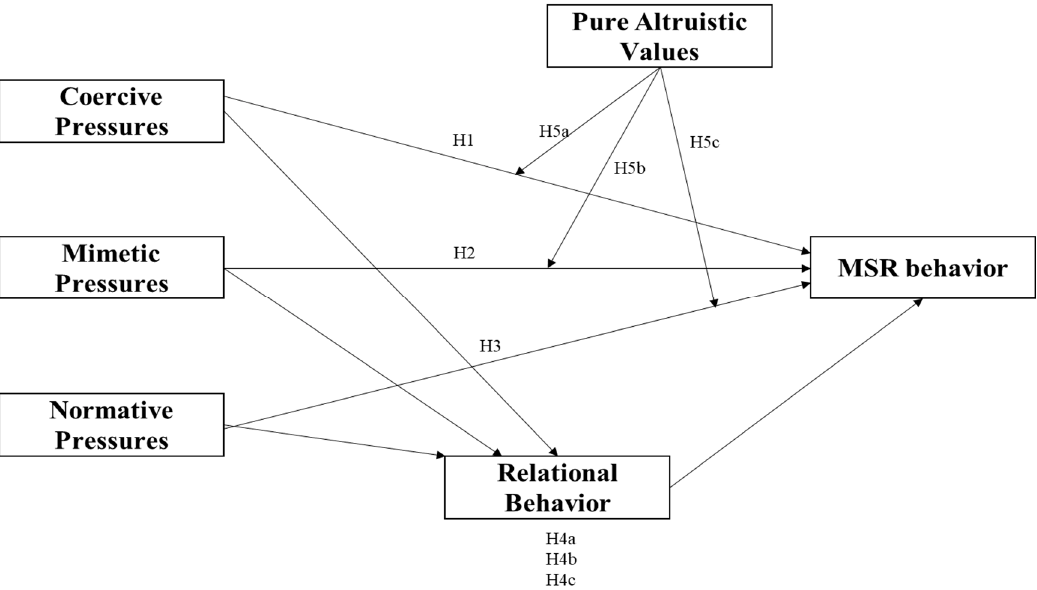
Figure 1. Conceptual model.